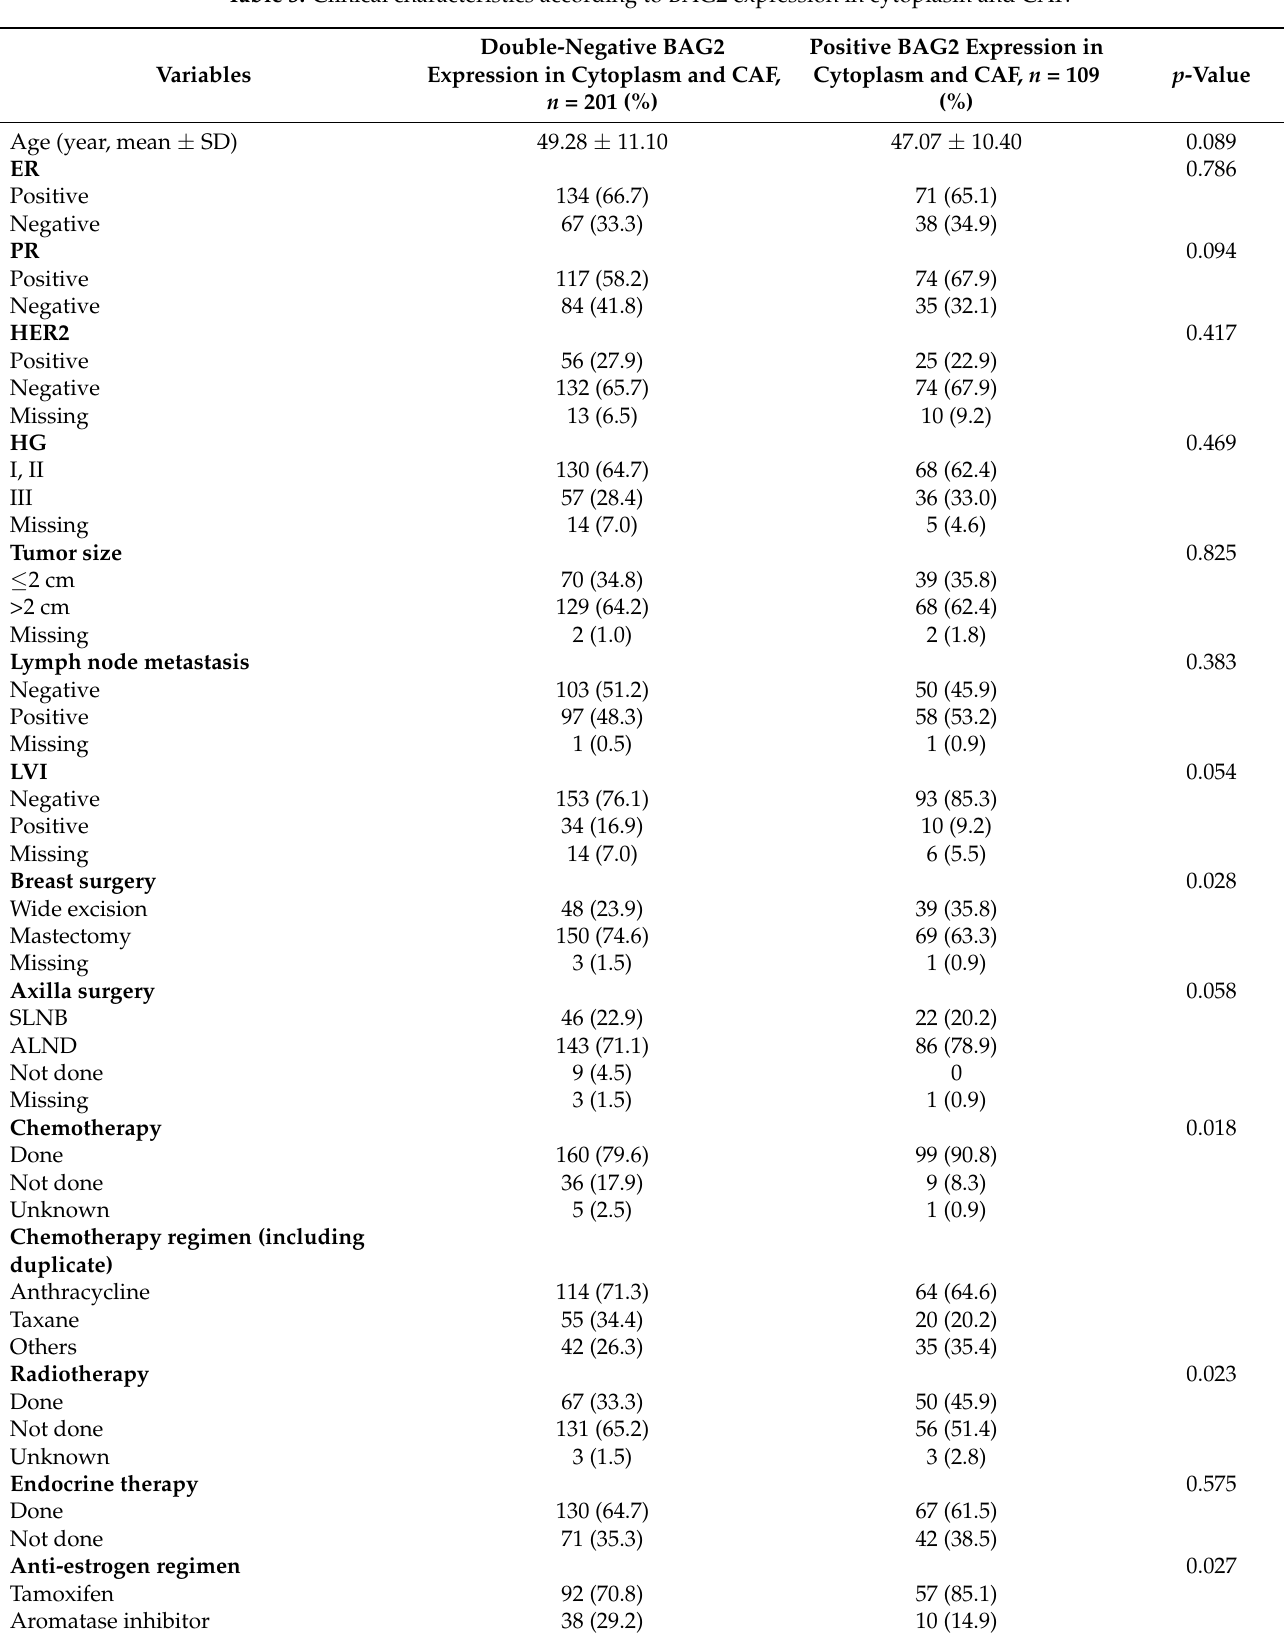
Table 3. Clinical characteristics according to BAG2 expression in cytoplasm and